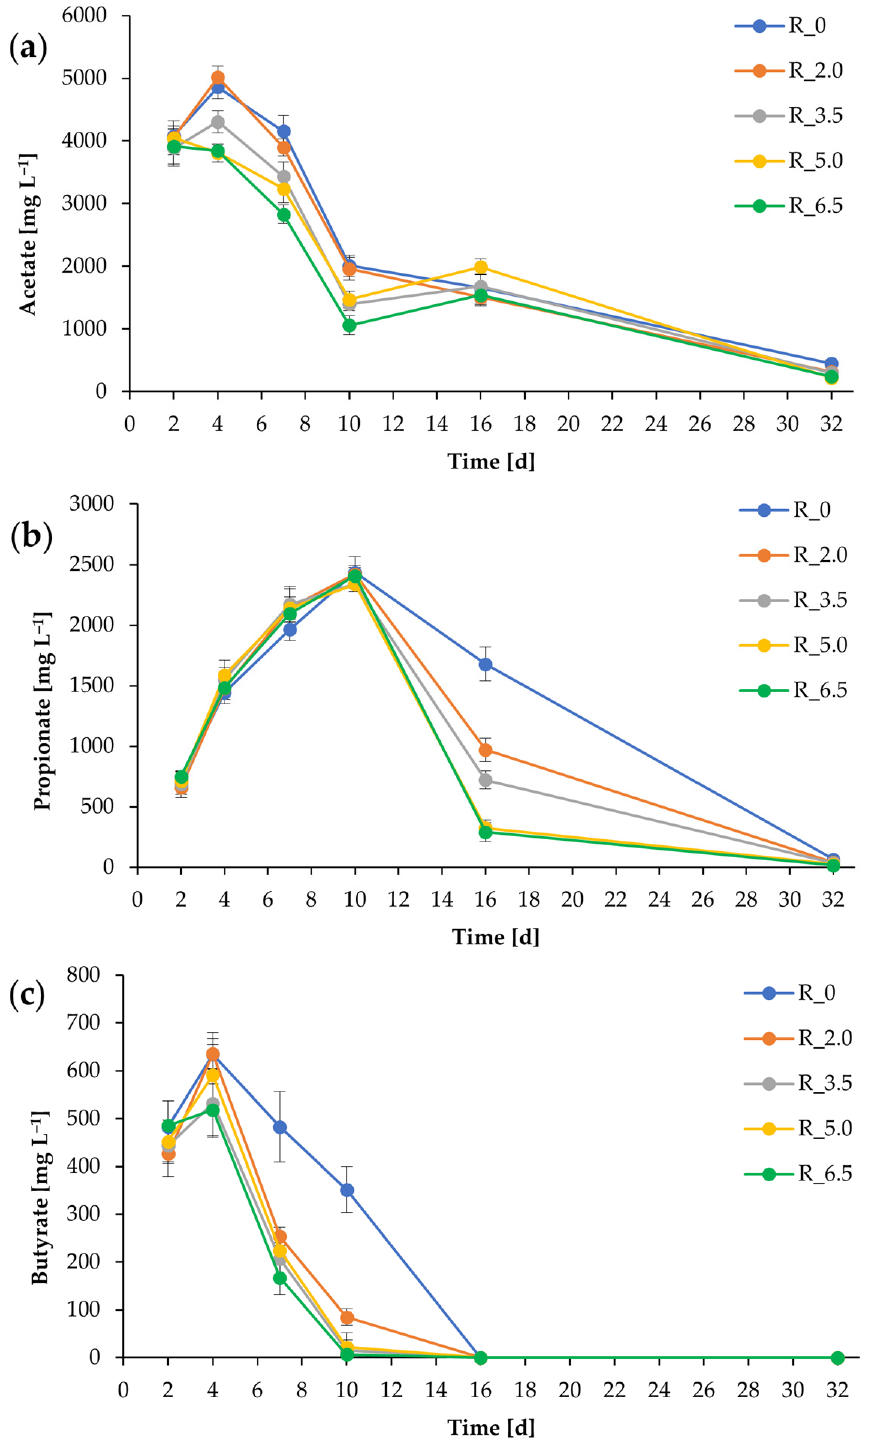
Figure 4. Impact of CNT addition on acetate ( a ), propionate ( b ), and butyrate ( c ) during the anaerobic digestion of chicken manure. Different concentrations of CNTs (2.0 g L − 1 , 3.5 g L − 1 , 5.0 g L − 1 , and 6.5 g L − 1 ) were added to the reactors (R_2.0, R_3.5, R_5.0, and R_6.5, respectively). R_0 operated without the addition of CNTs.